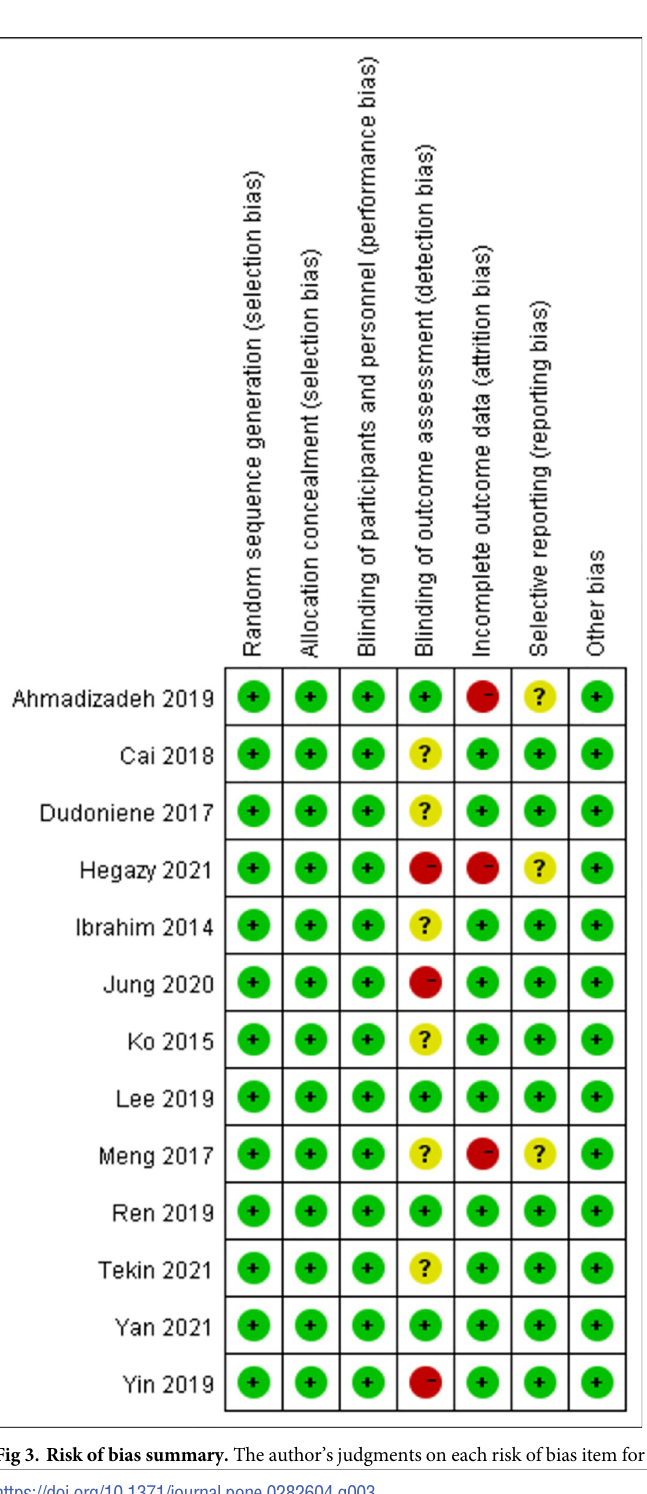
PLOS ONE | https://doi.org/10.1371/journal.pone.0282604 March 10,